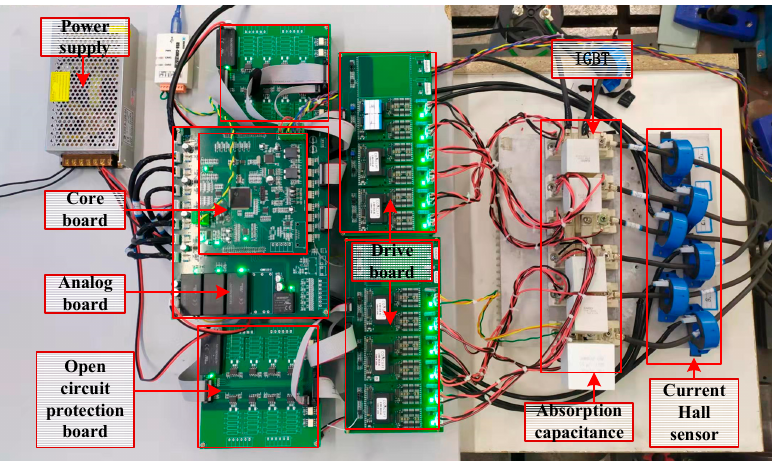
Figure 23. Experimental platform of the six-phase motor control system.